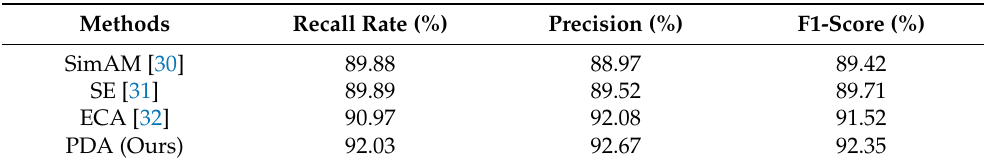
Table 3. Comparison with existing attention modules. These results indicate the performance before applying the refinement